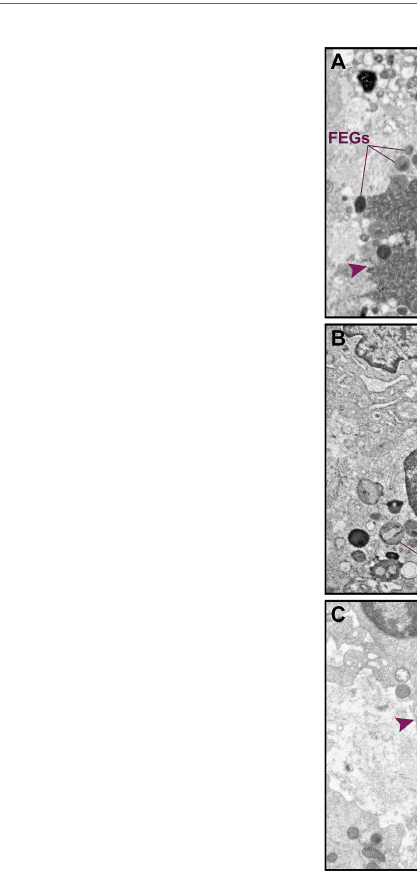
FIGURE 3 | Tissue eosinophils undergoing ETosis are seen in in fl ammatory sites in the proximity of intact eosinophils. (A – C) Electron micrographs of biopsy samples from eosinophilic chronic rhinosinusitis (ECRS), ulcerative colitis (UC) and hypereosinophilic syndrome (HES) patients, respectively, show eosinophils with nuclear changes typical of ETosis, characterized by chromatin decondensation, delobulation, rounding and expansion. Note that, while the nuclei (N) of intact eosinophils show typical distinction between euchromatin/heterochromatin, the nuclei (arrowheads) of ETotic eosinophils show only euchromatin. In (A) , the nuclear envelope was disrupted. Samples were collected from two patients with ECRS (n = 2), UC (n = 16), and HES (n = 2) and prepared for TEM. Gr, secretory granules; FEGs, free extracellular granules. LB, lipid